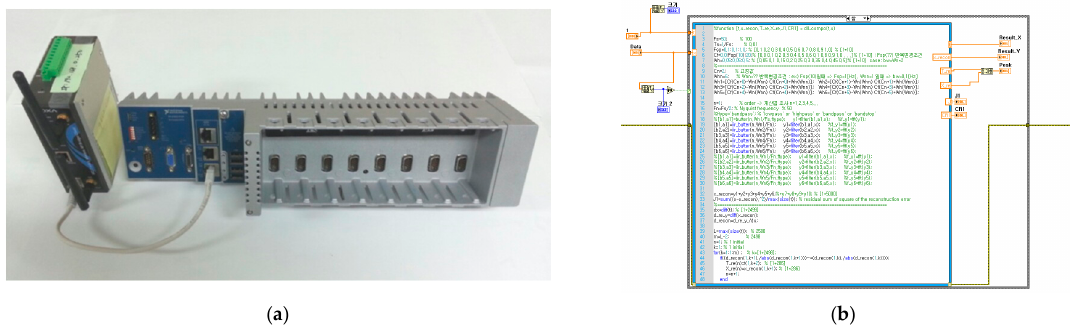
Figure 12. H/W and S/W for the IDAQ system: ( a ) EST-based DAQ (Controller); ( b ) Embedded AFB (optimal conditions).